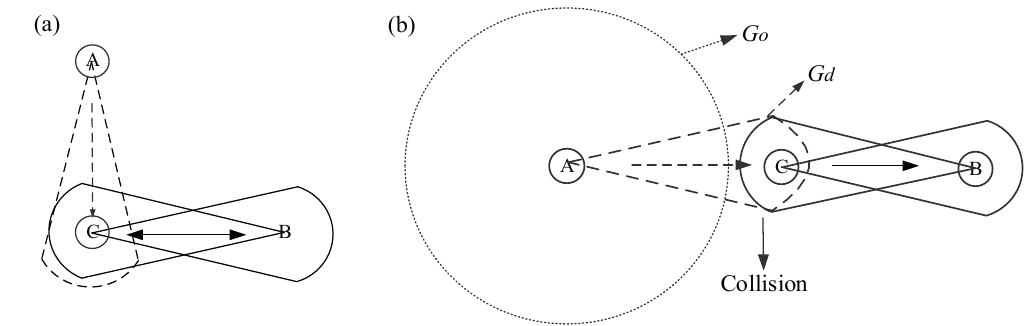
Figure 12. ( a ) A scenario to illustrate the deafness problem; ( b ) A scenario of hidden terminal due to asymmetry in